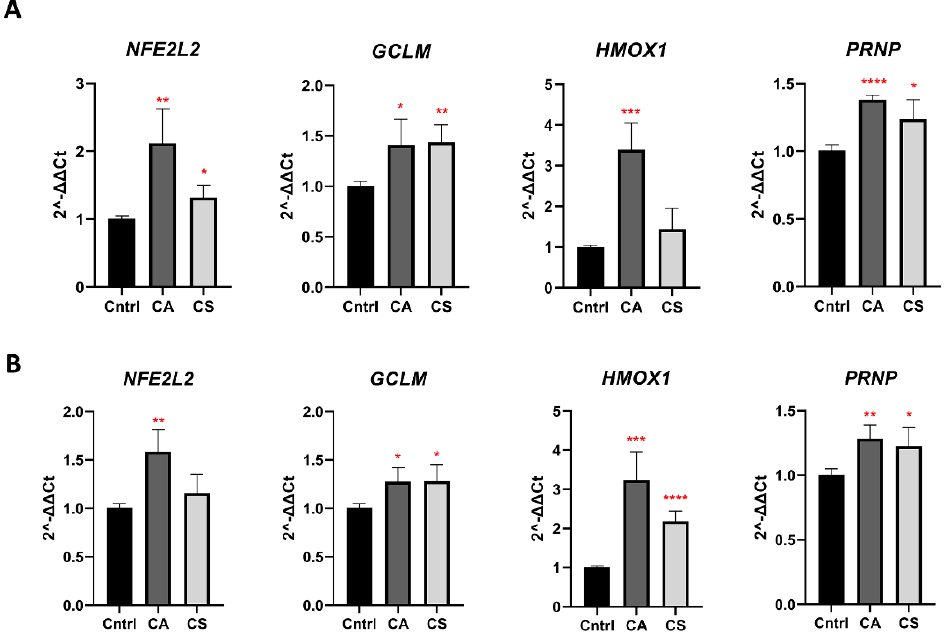
Figure 3. Treatment with CA and CS upregulates Keap-Nrf2 regulated genes and PRNP . qPCR for the expression of genes regulated by the antioxidant response Keap-Nrf2 pathway and PRNP was performed using mRNA extracted from N2a58 ( A ) and N2a22L ( B ) cells treated with 0.5 × LD 50 of CA or CS for 48 h and compared to non-treated control cells (Cntrl). 0.5 × LD50 was estimated at 14.84 μΜ for CA and 16.53 μΜ for CS for N2a58 and at 13.58 μΜ CA and 12.85 μΜ CS for N2a22L. Data represent means ± SD of three independent experiments. Stars denote statistical significance (unpaired, one-tailed, T -test); *: p -value < 0.05, **: p -value <0.01, ***: p -value < 0.001, ****: p -value < 0.0001. CA: dark grey, CS: light grey, Control: black.